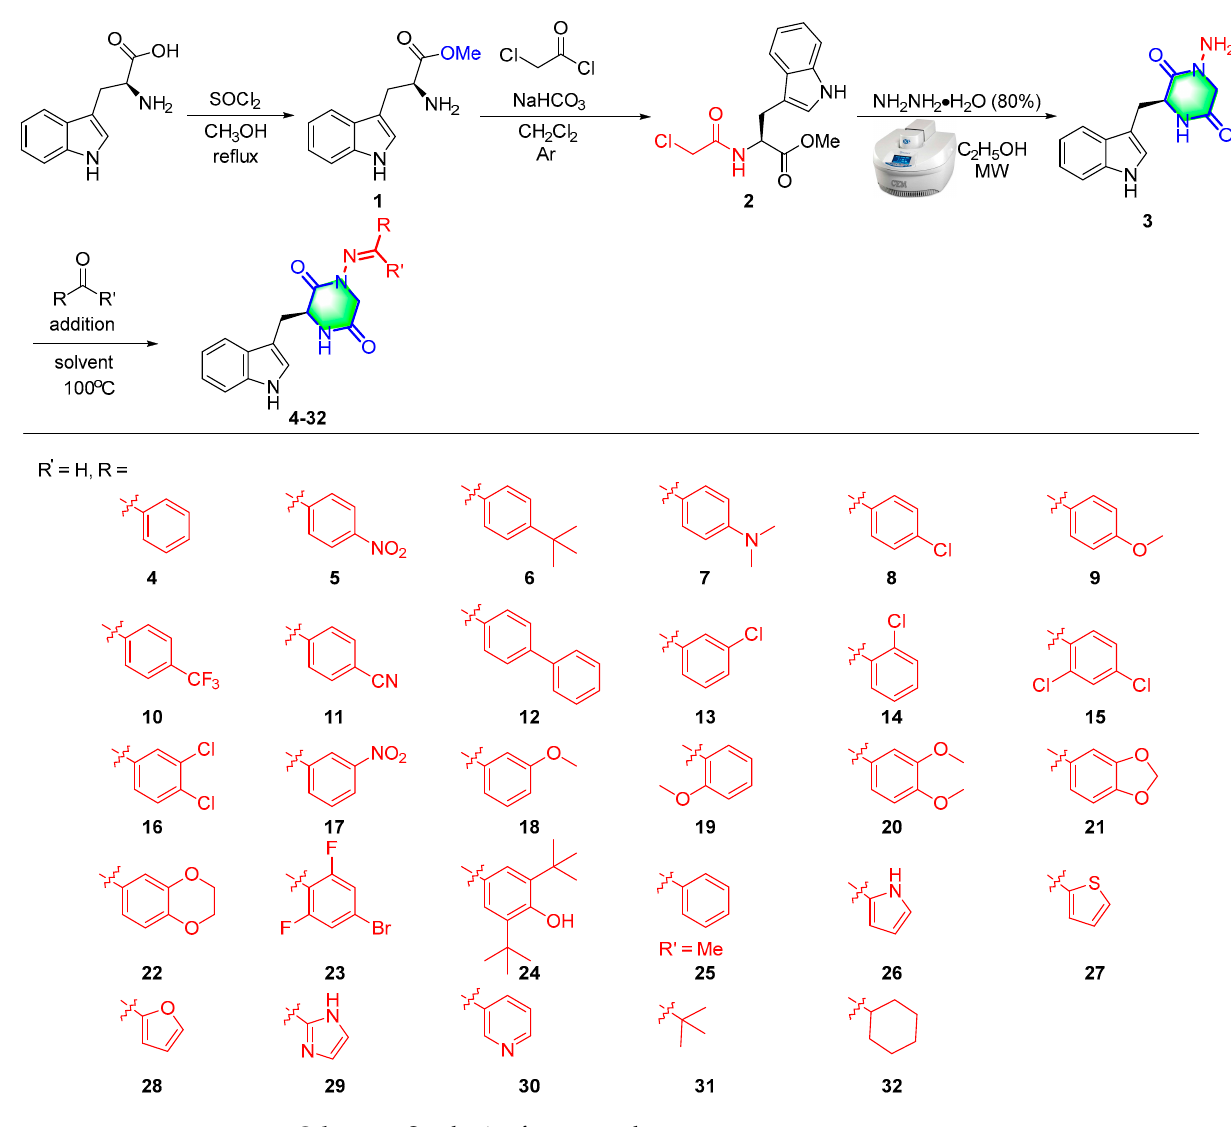
Table 1. Comparison between microwave reaction and conventional heating reaction for the cy- clization